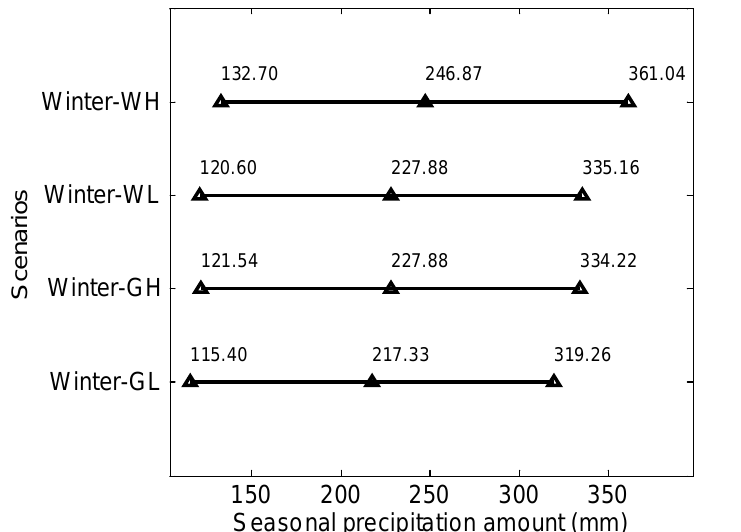
Figure 5. The assessment of KNMI’14 for winter precipitation around 2050. Derived from data in (KNMI,